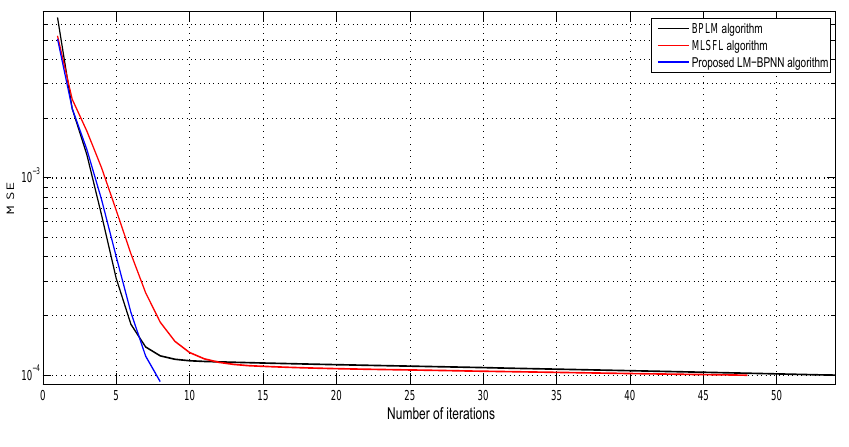
Figure 3. MSE of different